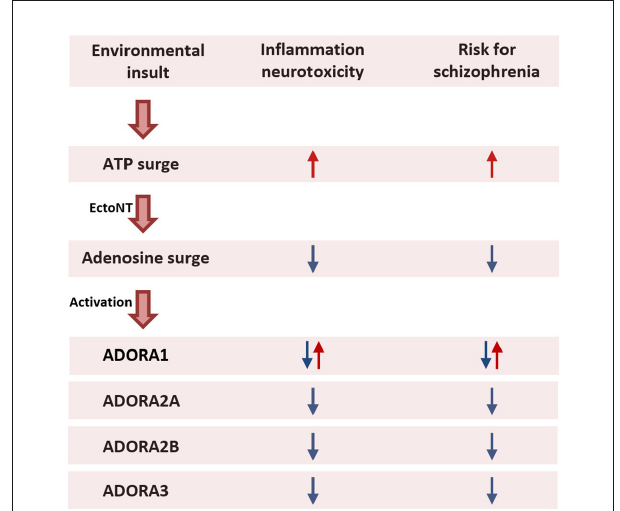
FIGURE3 Prenatal maternal exposure to environmental insults. Exposure to an environmental insult during pregnancy such as a viral infection activates the maternal immune system that evokes a cascade of pro- and anti-inflammatory events. An initial surge in ATP activates pro-inflammatory agents to fight the infection. The increased production of ATP is followed by a secondary surge in adenosine production through enzymatic degradation of ATP by EctoNTs. Mediated via ADORA2A, ADORA2B, and ADORA3 located on the surface of immune cells, adenosine triggers an anti-inflammatory response to limit the spread of the inflammation and prevent excessive tissue damage (Haskó et al., 2005; Abouelkhair, 2020; Franciosi et al., 2021). The pro-inflammatory action of ATP disturbs fetal brain development and therefore increases the risk for the offspring to develop schizophrenia later in life. By contrast, the anti-inflammatory action of adenosine protects the fetal brain from the harmful effects of the inflammation. Consequently, augmenting adenosine in pregnant women during an infection may reduce the risk for schizophrenia in the offspring. While the anti-inflammatory action of adenosine is mediated via ADORA2A and ADORA2B and possibly ADORA3, it remains unclear whether activation of ADORA1 is protective or harmful to fetal brain development. Abbreviations : ADORA1,